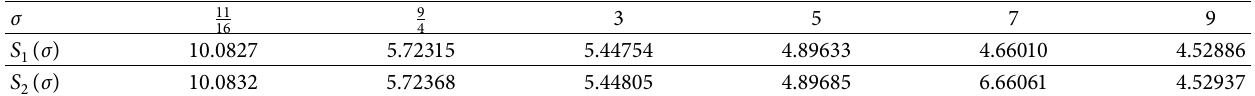
Figure 2: Graphics of H Table 2: The numerical results for S ( σ )